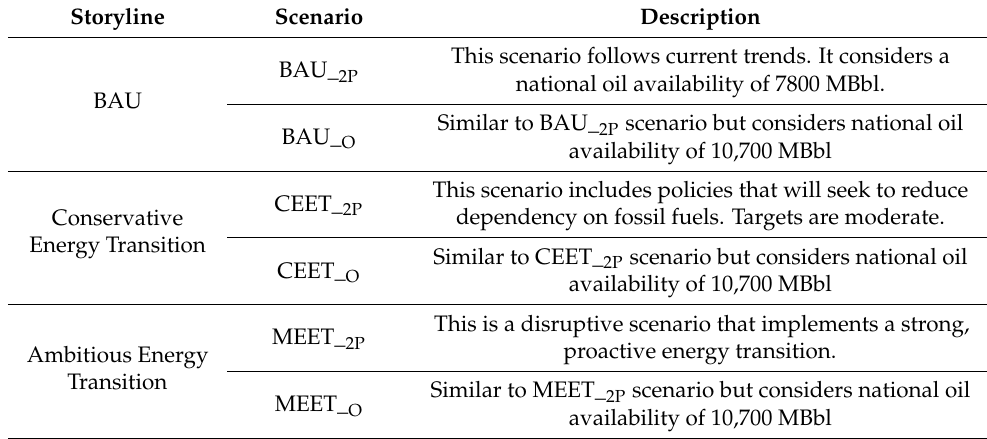
Table 1. Scenarios modeled in